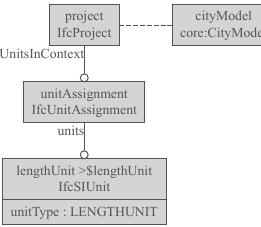
Figure 9. A rule extracting the default length unit from IfcProject to store it in the context variable $lengthUnit.